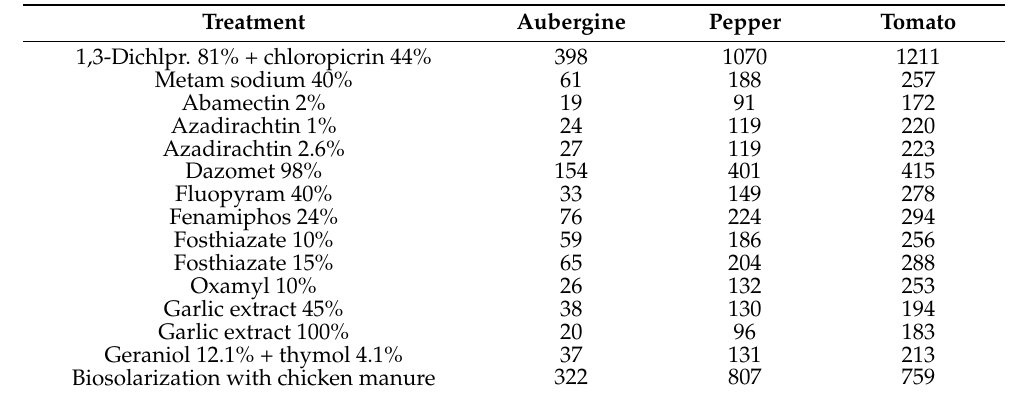
Table 6. Maximum pre-treatment RKN ( M . incognita ) densities (P0) that each nematicidal treatment could manage to get RKN densities at planting (Pi) equal to the economic threshold level in intensive solanaceous crops in southern